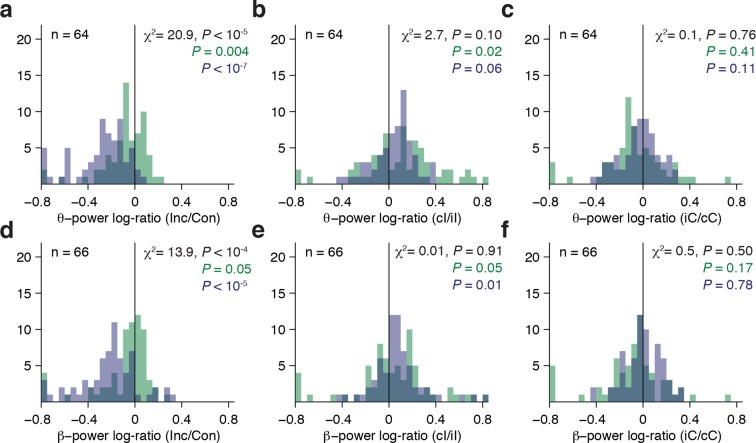
Theta and Beta band population results.(A) Distribution of theta power log-ratio (Incongruent/Congruent) for the Stroop task (blue) and Reading task (green). Bin size = 0.05. P values in black denote interaction statistics whereas P values in blue and green denote the statistics for the Stroop and Reading tasks respectively. As discussed in Figure 4, the average log-ratios are presented here for display purposes only and the statistical tests are based on the raw power values. (B) Distribution of the gamma power log-ratio between incongruent trials preceded by congruent trials (cI) compared to incongruent trials preceded by incongruent trials (iI). (C) Distribution of the gamma power log-ratio between congruent trials preceded by incongruent trials (iC) compared to congruent trials preceded by congruent trials (cC). (D-F) Same as (A-C), but for power in the beta band.